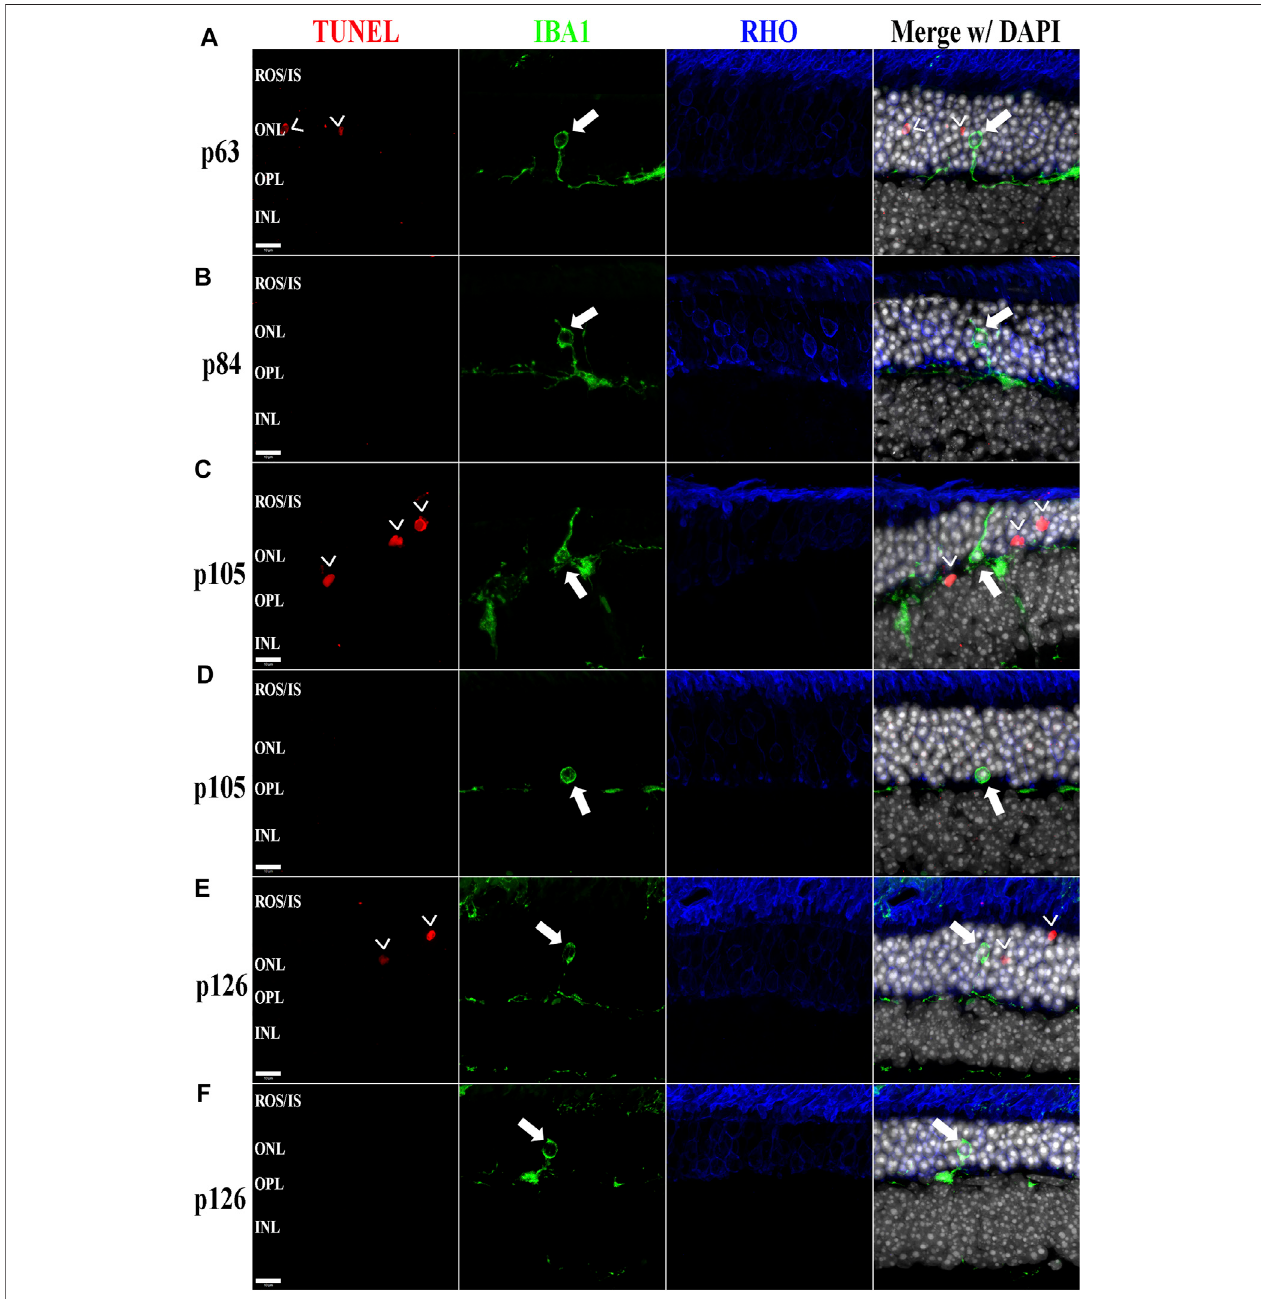
FIGURE 6 | The BXD32 mouse retina shows aberrant phagocytosis of living photoreceptors by monocytes. Using TUNEL labeling (red) for apoptotic nuclei (arrowheads, > )and immunolabelingformonocytes(IBA1, green) andphotoreceptors(RHO,blue)atp63 (A) ,p84 (B) ,p105 (C,D) , and p126 (E,F) ,monocytesofeither microglial or bloodborne origins can be observed phagocytosing non-apoptotic photoreceptors (arrows), a process known as phagoptosis. Nuclei stained with DAPI (white/grey). ROS/IS, rod outer segments/inner segments; ONL, outer nuclear layer; OPL, outer plexiform layer; INL, inner nuclear layer. Scale bars = 10 μ m.